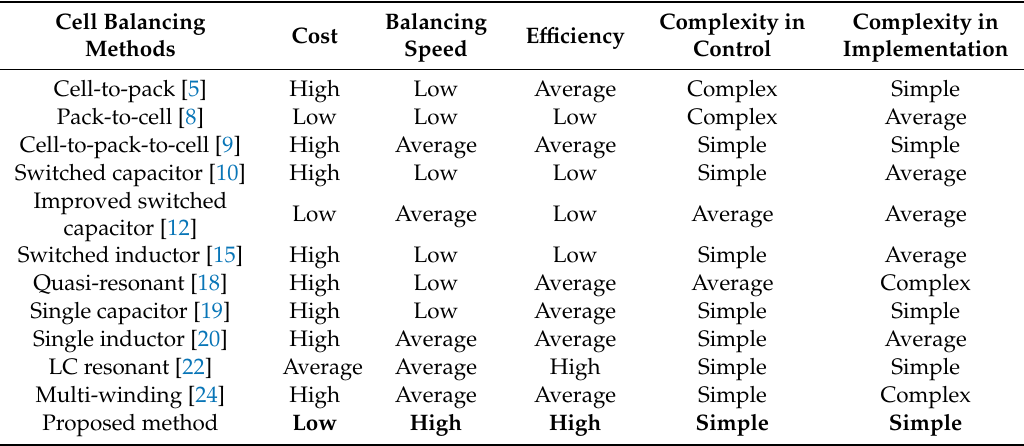
Table 3. Comparison of the proposed cell balancing method for N-cells in the